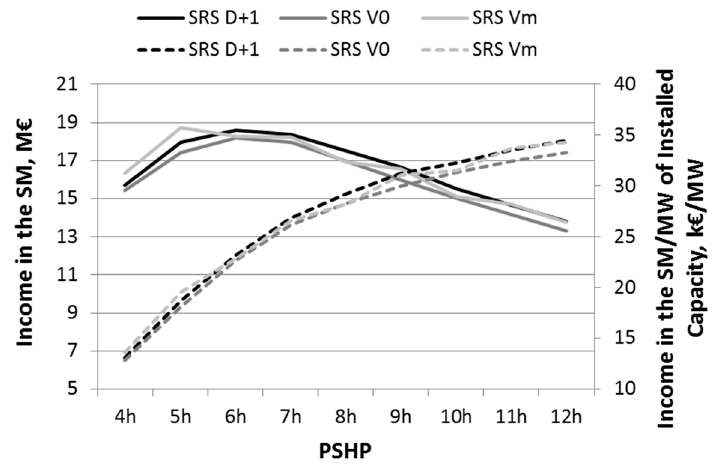
Figure 6. Annual maximum theoretical income in the SM (solid lines) and per MW of the installed capacity in generating mode (dashed lines) of each PSHP.